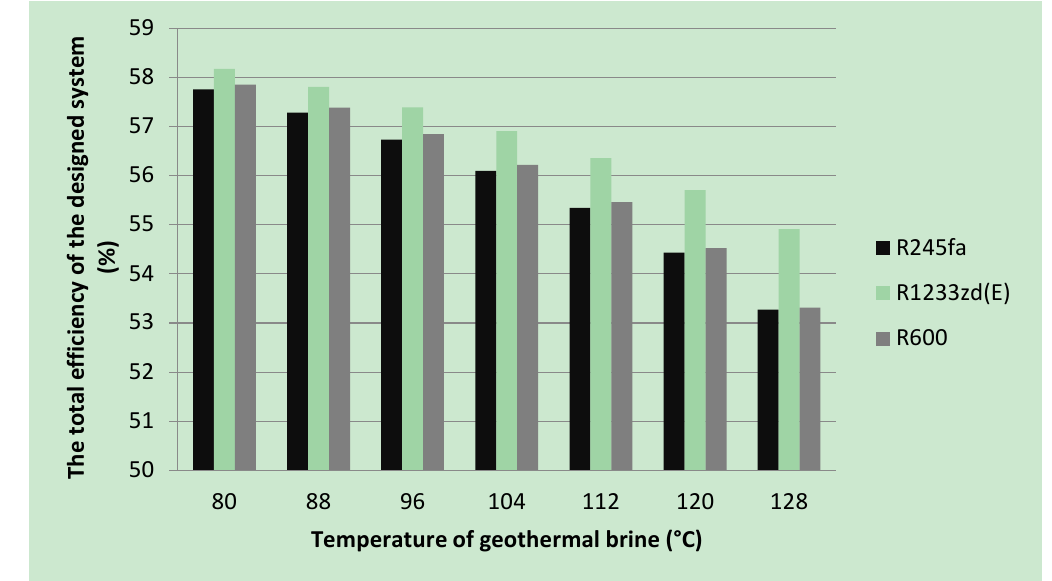
Figure 6. The total efficiency of the modified ORC system (assisted by gas turbine) as a function of the geothermal brine temperature.